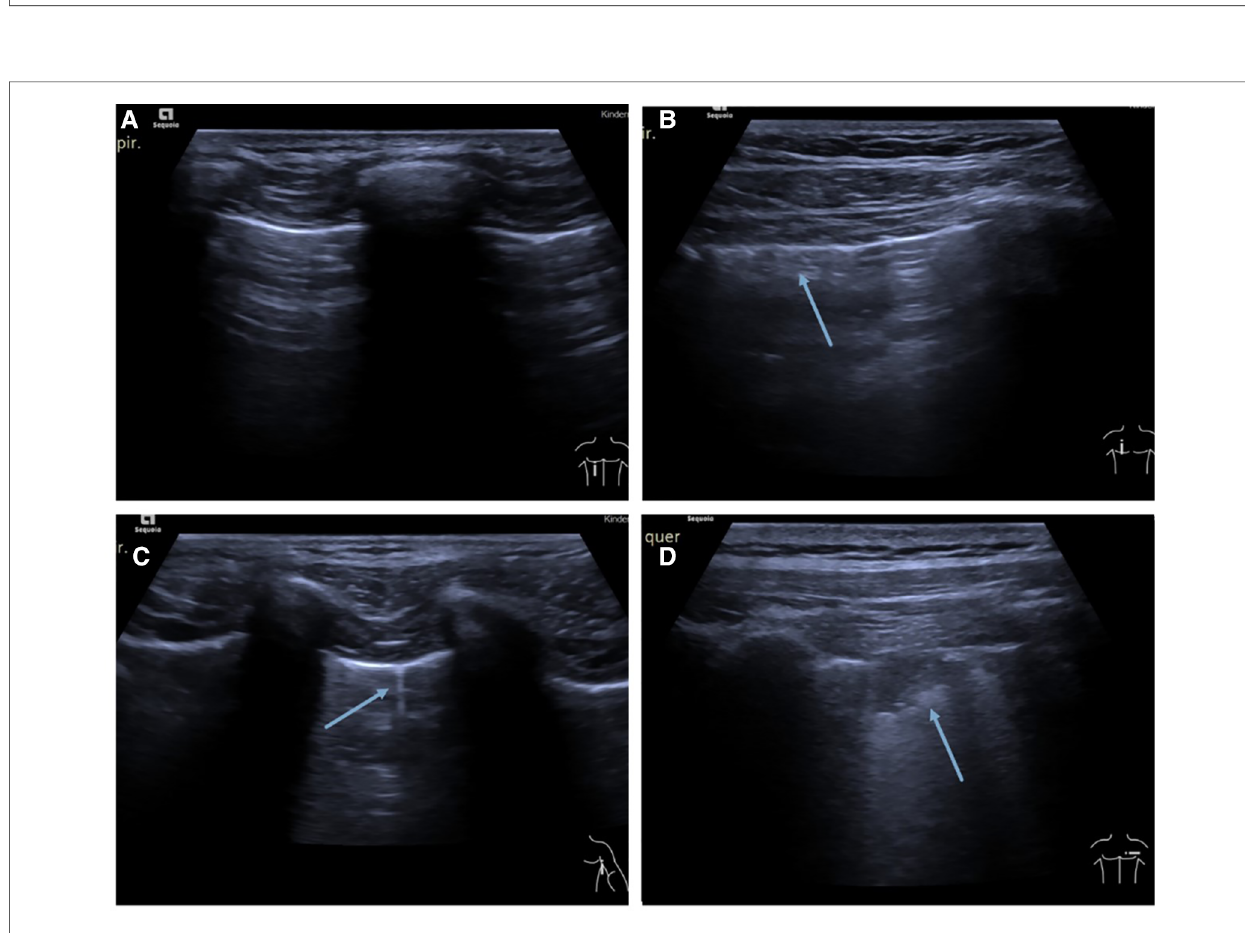
FIGURE 2 ( A ) Example of a normal lung ultrasound. Picture showing a typical A-line pattern. ( B ) Lung ultrasound picture showing pleural irregularity (arrow). ( C ) Example of a typical B-line (arrow). ( D ) Example picture of a typical consolidation